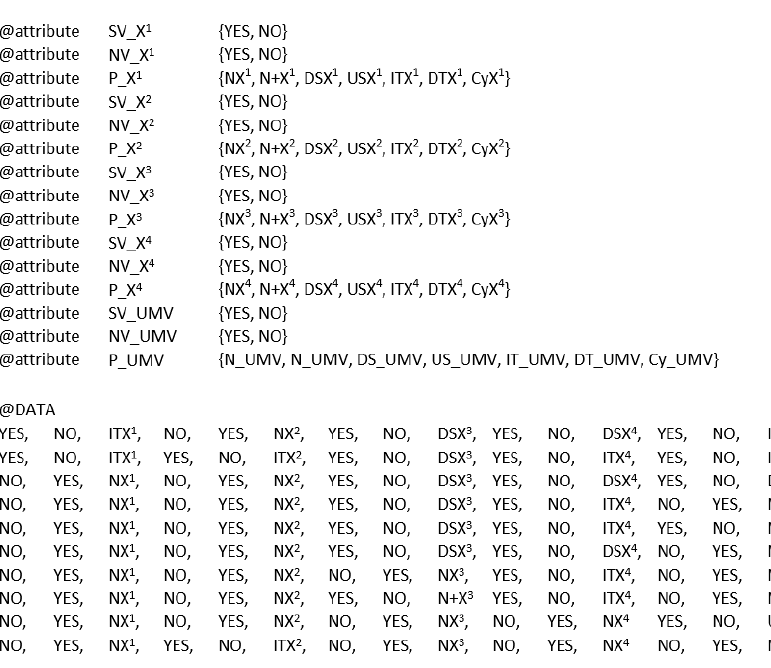
Figure 6. Structural arrangement of the patterns found in Moving Windows ( MWs